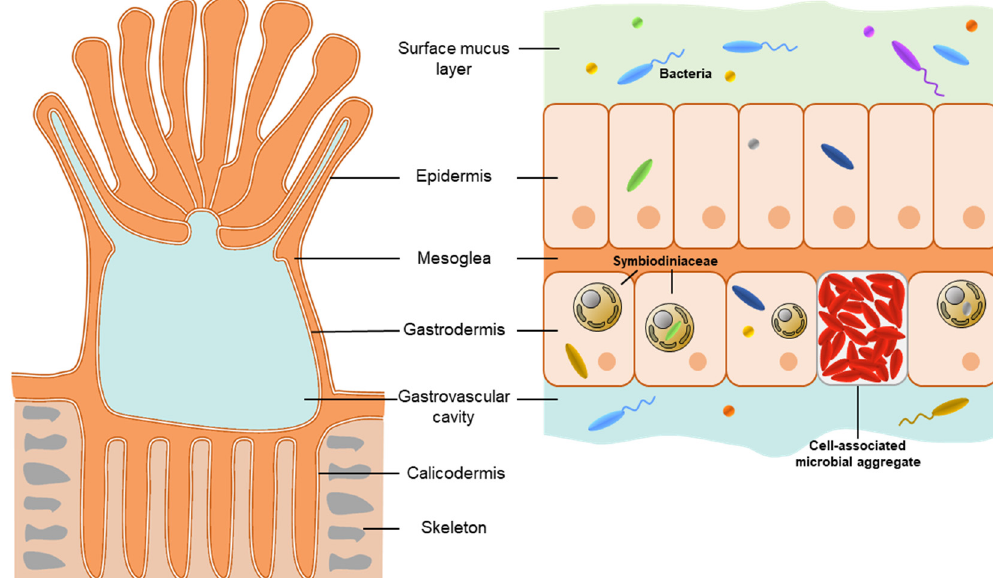
Figure 1. Coral anatomy and microbial associations. A coral colony is composed of many identical polyps (left panel shows an individual polyp), connected by interlaying tissues and sharing a calcium-carbonate skeleton. Each polyp is composed of two cellular layers, the epidermis and the gastrodermis, separated by a largely acellular layer, the mesoglea, although it contains fibroblasts and amoebocytes [55]. The epidermis is covered by the surface mucus layer, where bacteria are highly abundant [42]. Symbiodiniaceae reside in the gastrodermis but are found in the mucus as well [56,57]. Intracellular bacteria and cell-associated microbial aggregates can occur in both cellular layers. Symbiodiniaceae cells have also been reported to harbor intracellular bacteria [51]. Other microorganisms, including viruses [58], archaea [59], fungi [60], and other eukaryotes [61,62], associate with corals and are not represented in this